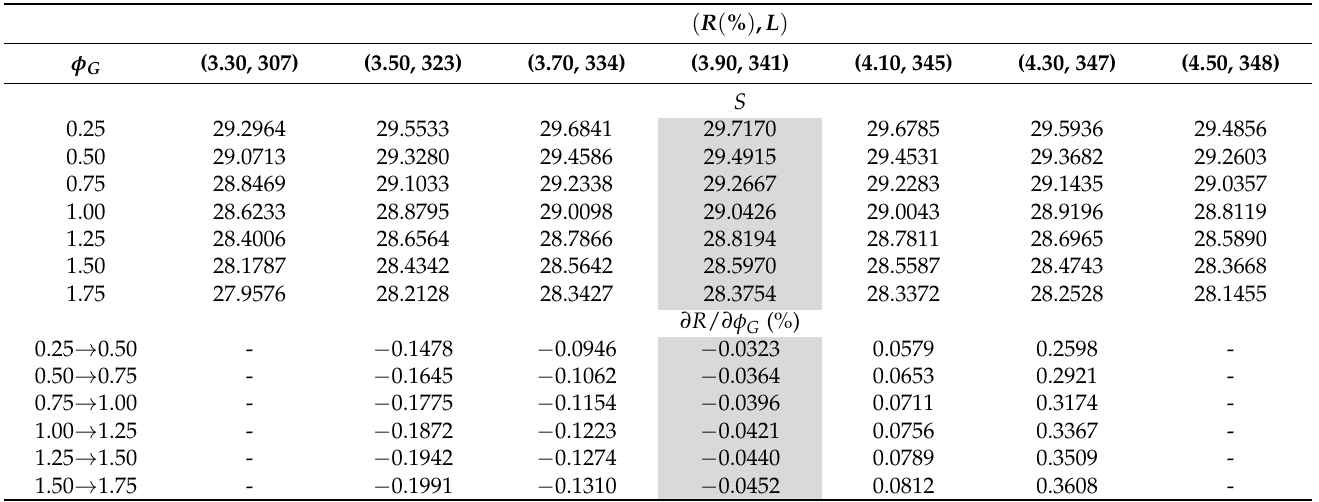
Table 8. Responsiveness of the optimal guaranteed rate to φ G